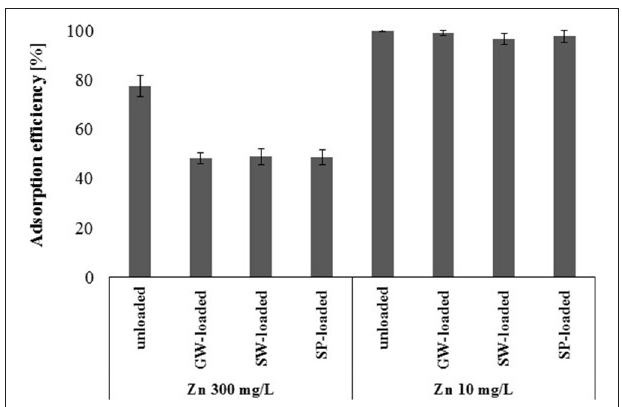
FIGURE 10 | Adsorption efficiency of the unloaded and ground water-(GW), surface water-(SW), and sediment pond water (SP)-loaded gBIOs with regard to zinc at two concentrations (mean ± SD, n =